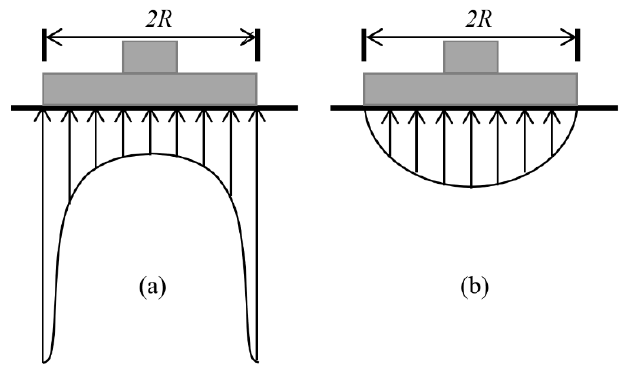
Figure 4. Assumed contact pressure distribution of smooth rigid footing on ( a ) cohesive soil and ( b ) cohesionless soil.